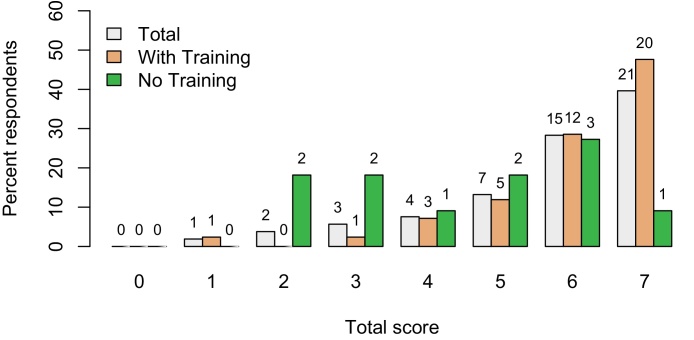
Distribution of total hazard identification scores among 53 catchers, and among those who stated that they had previously received biosecurity training (‘With training’, n = 42) and those reporting never having received training (‘No training’, n = 11). Total score represents the number of hazards identified by each respondent, out of a maximum of 7. The numbers above each bar indicate the number of individuals within that category.